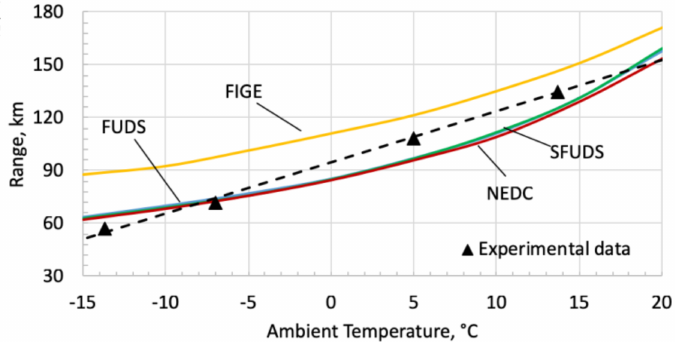
Figure 3. Results of the model